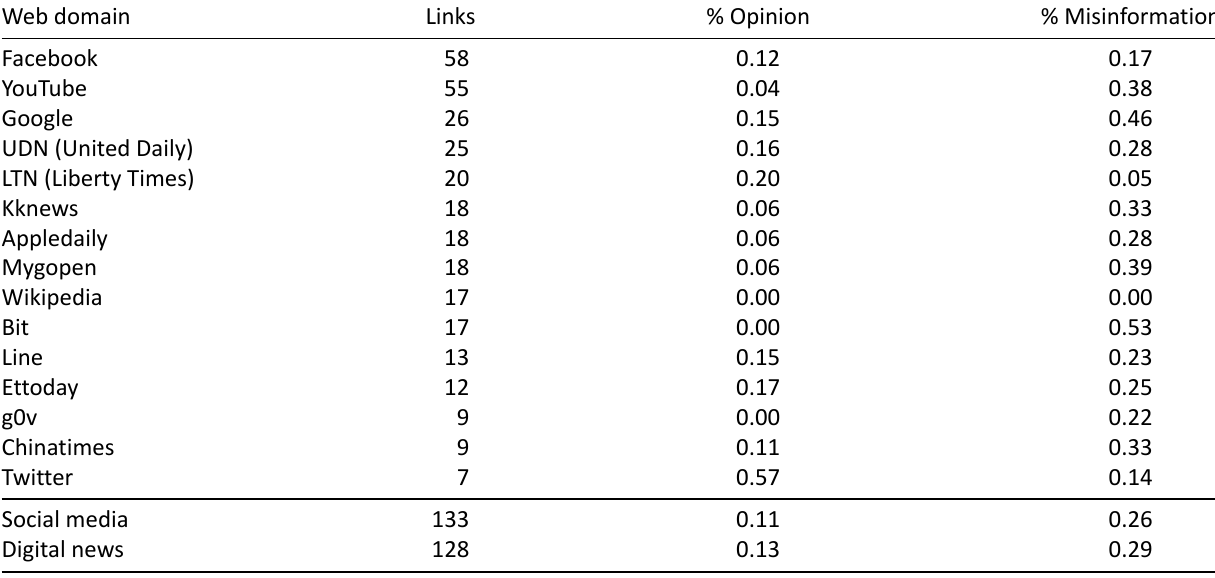
Table 7. Top reported misinformation domains and their proportions of misinformation and opinion. Web